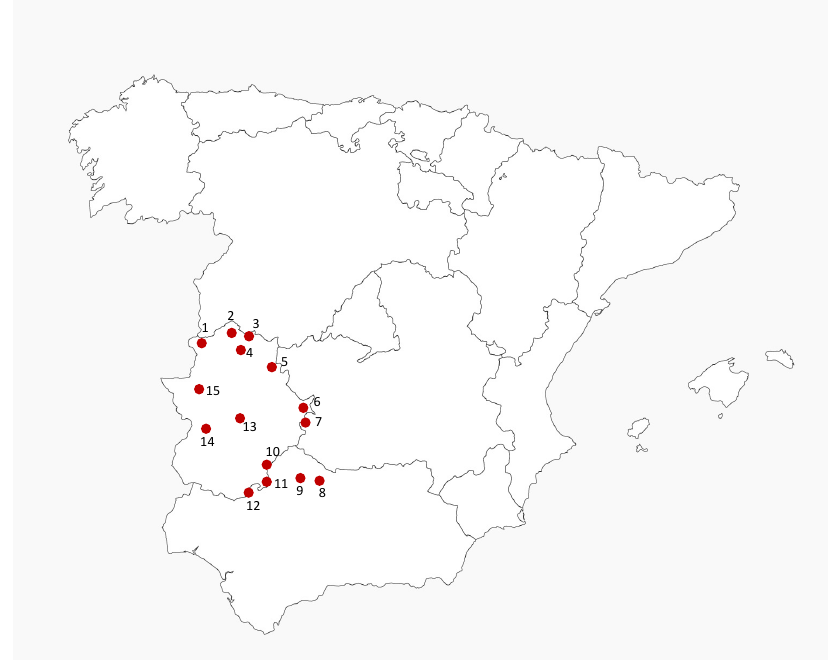
Figure 3. Physical map of Spain showing the location of the different game estates investigated in this study. Numbers identify the different geographical locations of samples.